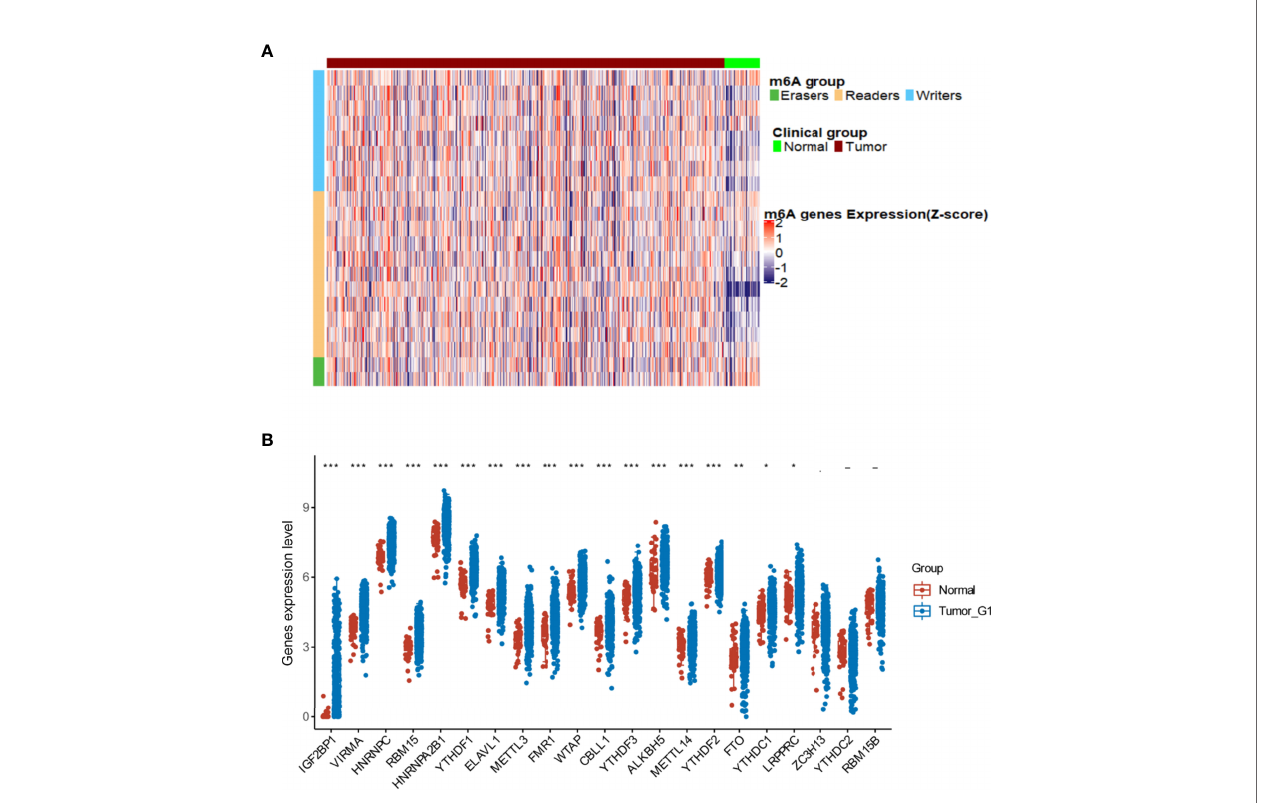
FIGURE 2 | Alterations in m6A regulators in The Cancer Genome Atlas- head and neck squamous cell carcinoma (HNSCC) patients. (A) Heatmap showing the expression of m6A regulators in tumor and normal tissues. (B) Differences illustrated in expression levels between HNSCC (blue box) and normal (red box) tissues for 21 m6A regulators. For t-test: ns, p ≥ 0.05; * p < 0.05; ** p < 0.01; *** p <